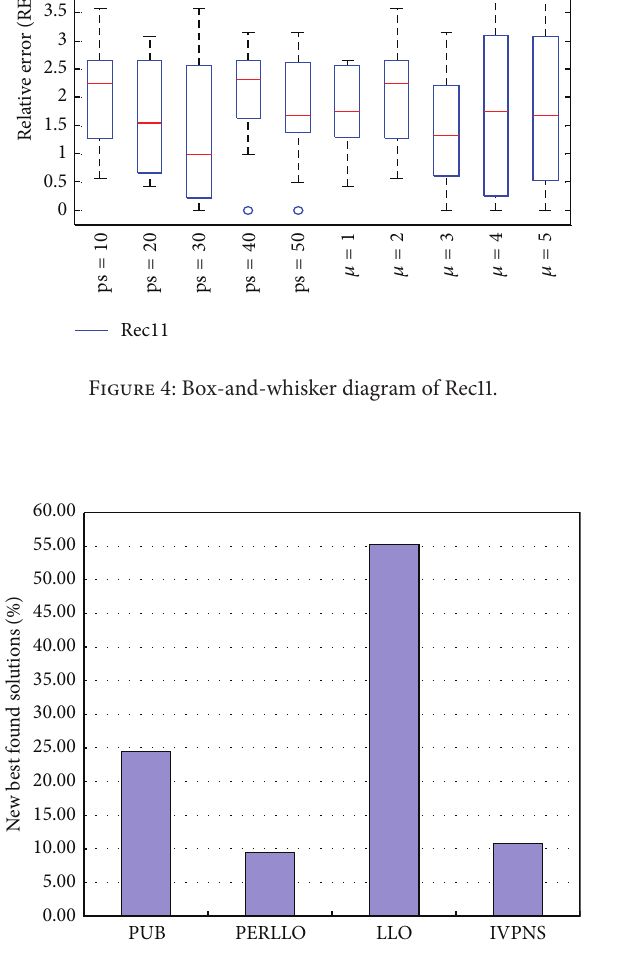
Figure 5: The contribution of each strategy move to finding a new best